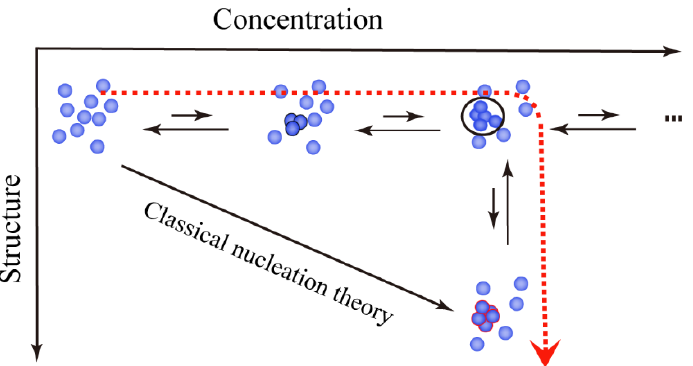
Figure 3. Microscopic views on the (Concentration, Structure) plane during the two-step nucleation process and classical nucleation process. The figure is reproduced with copyright permission of ref. [33].